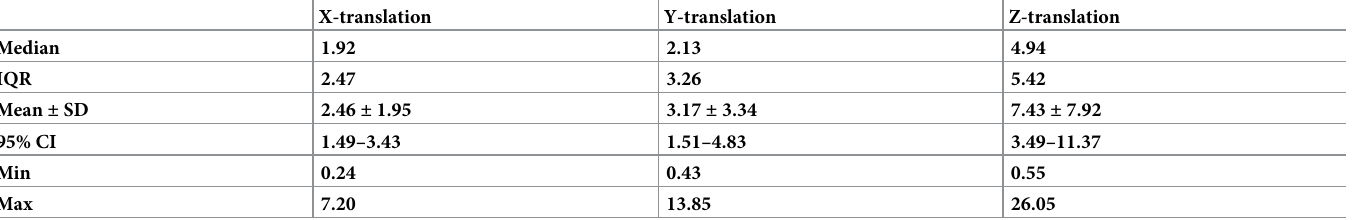
Table 2. Absolute translational deviations (in mm) between the planned cochlear implant (CI) and the implanted CI calculated of the center of the magnet for each CI type with the landmark based